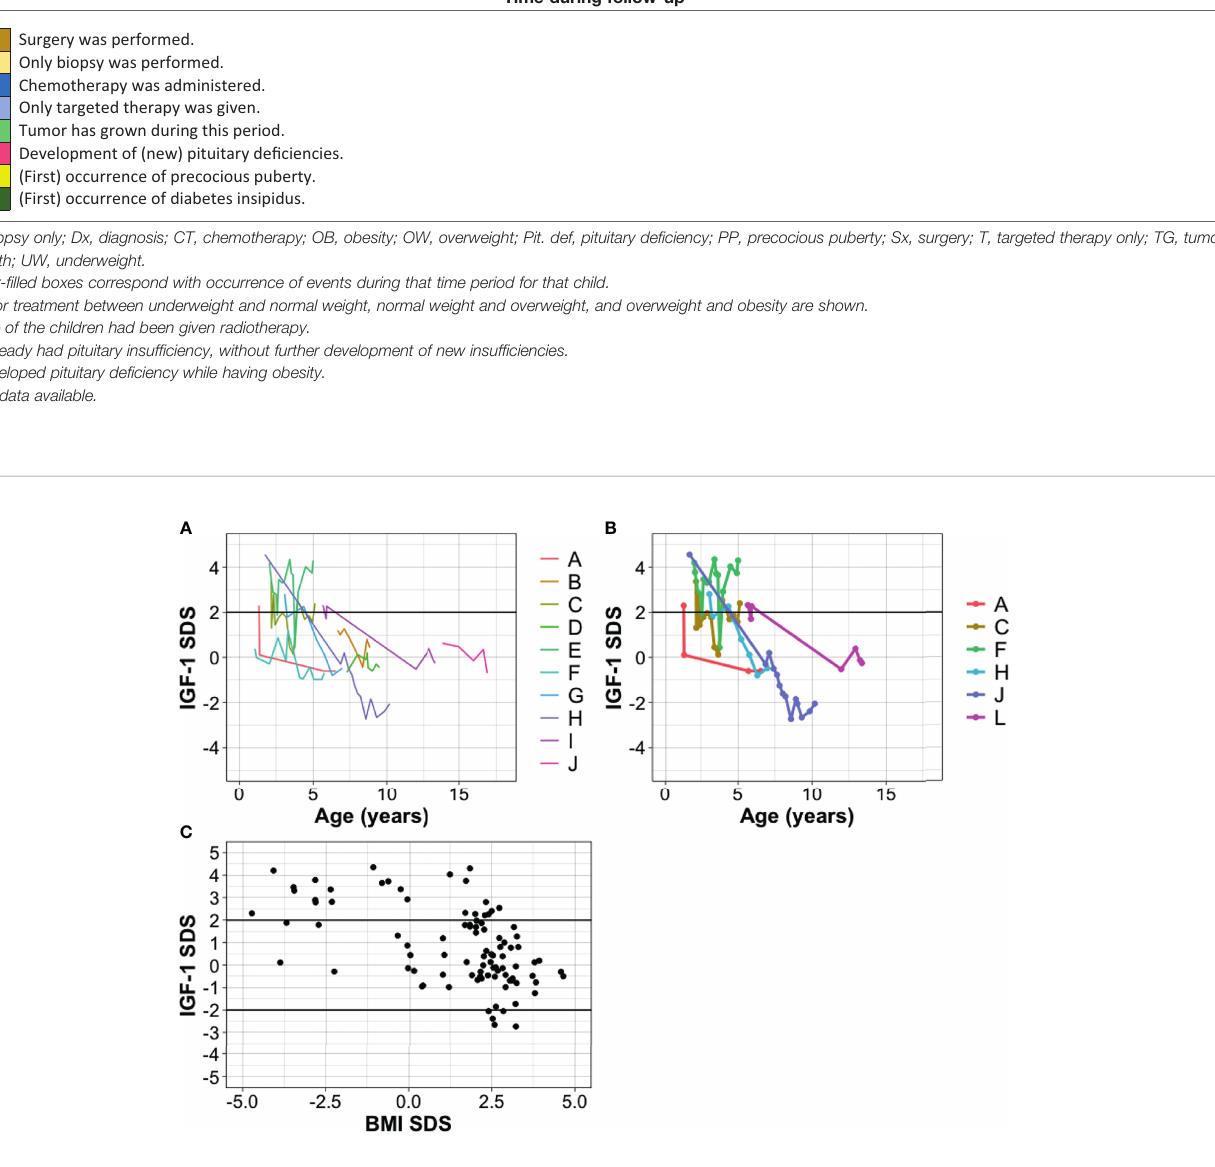
FIGURE 4 | Longitudinal IGF-1 SDS over time in children with suprasellar LGG presenting with DS. Legend shows patients in correspondence with Table 2 and Figure 2 . (A) IGF-1 SDS values over time in all patients. x-axis: age in years at time of measurement, y-axis: IGF-1 SDS corrected for age and gender. (B) IGF-1 SDS values over time for patients with GH hypersecretion only (for 1 patient with GH hypersecretion, data on IGF-1 values over time were missing). (C) BMI SDS (x-axis) according to IGF-1 SDS (y-axis) in all patients. Correlation coef fi cient for BMI-SDS and IGF-1 SDS: − 0.37 (p <0.001). Only IGF-1 values without growth hormone treatment or use of somatostatin analogues are shown.